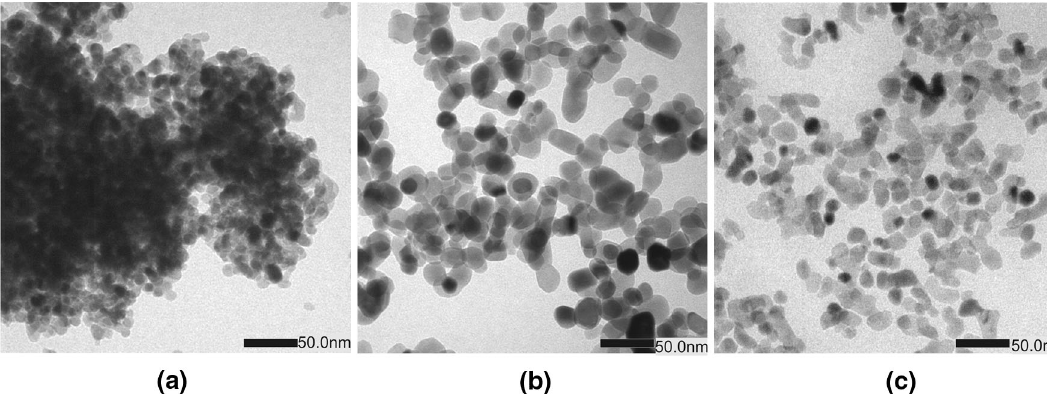
Fig. 2 TEM micrograph of samples a Z, b MZ, and c MZS